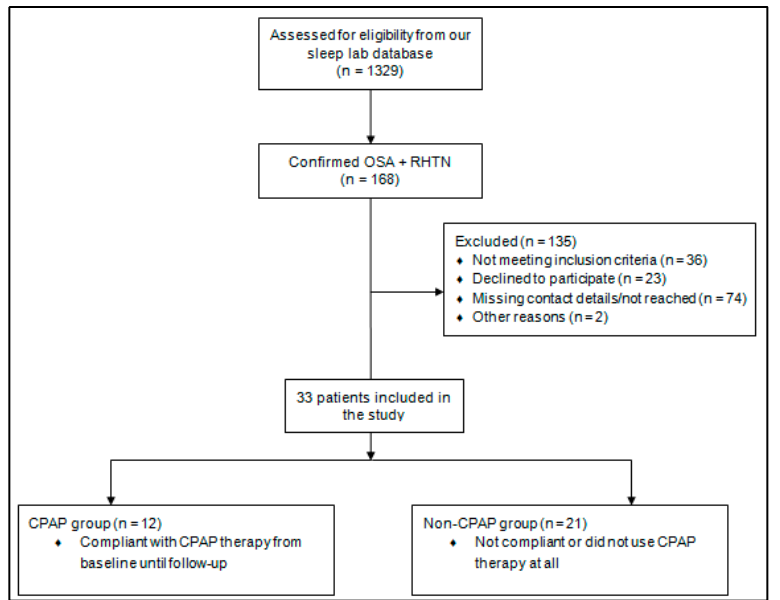
Figure 1. Flowchart of the study design. (OSA—obstructive sleep apnea; RHTN—resistant Figure1. Flowchartofthestudydesign. (OSA—obstructivesleepapnea; RHTN—resistanthypertension; hypertension; CPAP—continuous positive airway pressure). CPAP—continuous positive airway